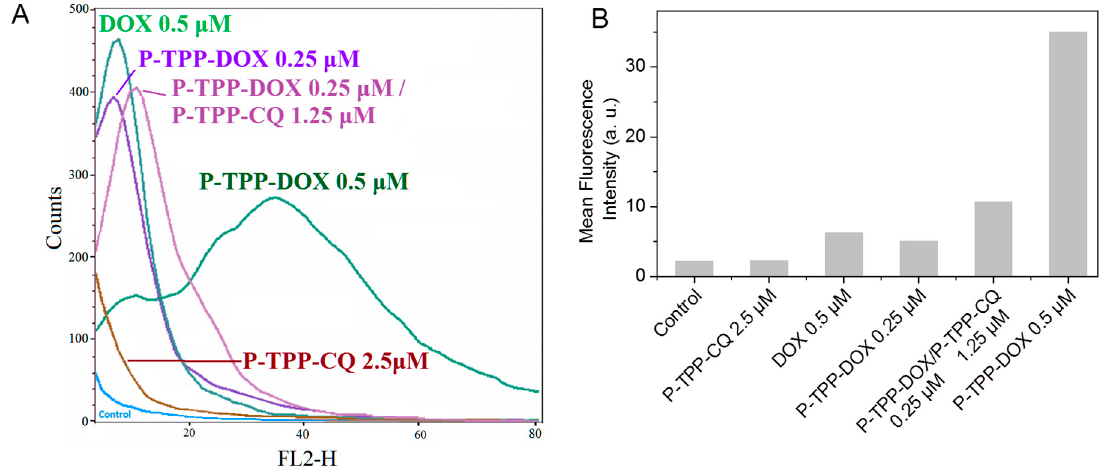
Figure 1. ( A ) Flow cytometry profiles of DOX fluorescence and ( B ) quantitative analysis of mean fluorescence intensity within DU145 human prostate cancer cells incubated with free DOX (0.5 μ M), with P-TPP nanocarrier encapsulating DOX (P-TPP-DOX, DOX concentrations 0.25 μ M and 0.5 μ M) or chloroquine (P-TPP-CQ, CQ concentration 2.5 μ M) and with both P-TPP-DOX and P-TPP-CQ (P-TPP-DOX 0.25 μ M/P-TPP-CQ 1.25 μ M).